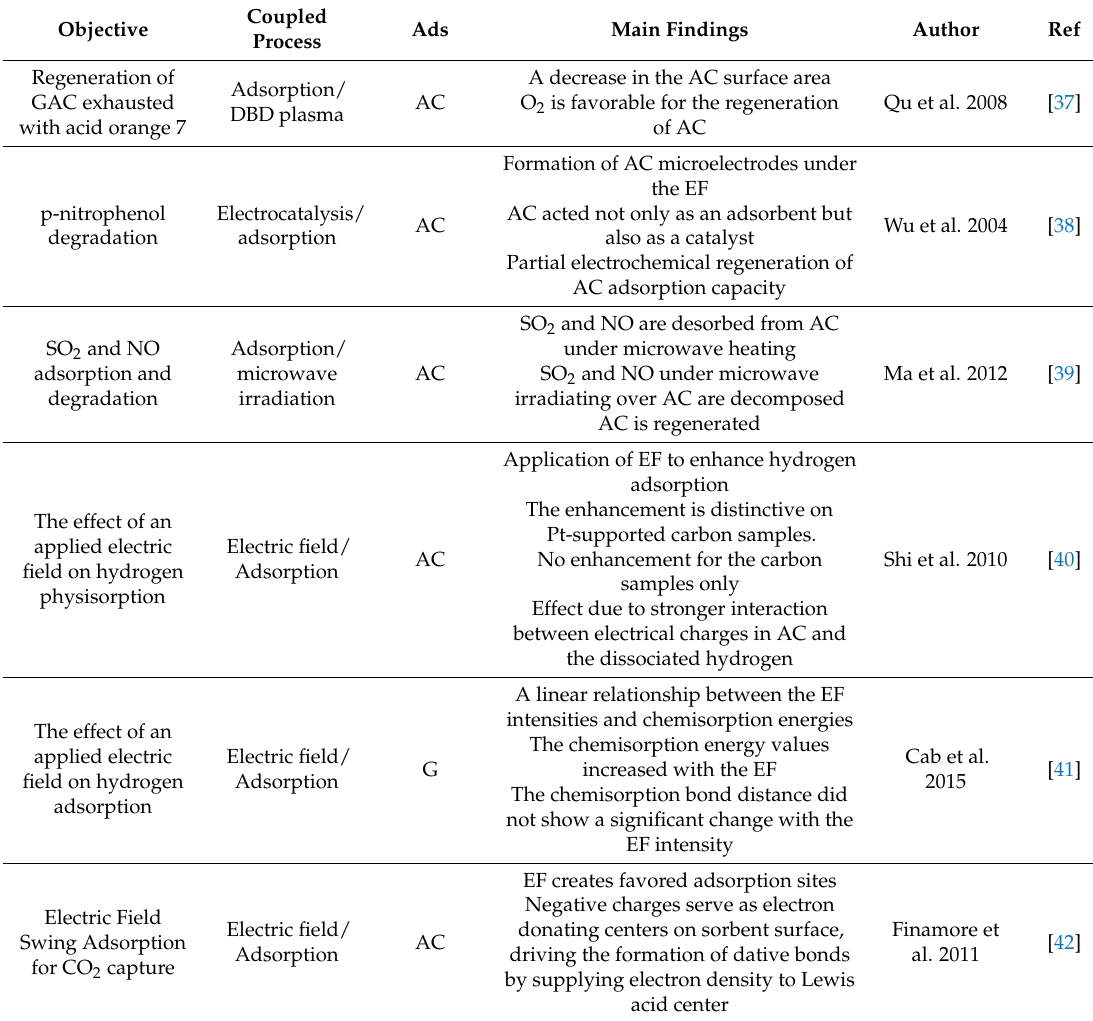
Table 3. Summary of publications in which an electric field has been applied to a carbonaceous adsorbent